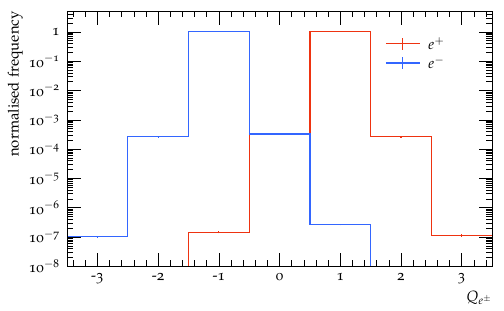
Figure 7 . The total charge of the cone-dressed electron and positron with ∆Θ dress = 0 . 1 and including all secondary flavours, i.e. f dress = . γ, e, π, K, µ, τ { } dressing with ∆Θ = 0 . 1 . Fewer than a thousandth of the dressed leptons are neutral dress or doubly charged, while a fraction of 10 − 7 of them are either triply charged or appear to be their own antiparticle (a dressed electron having a charge of +1 or a dressed